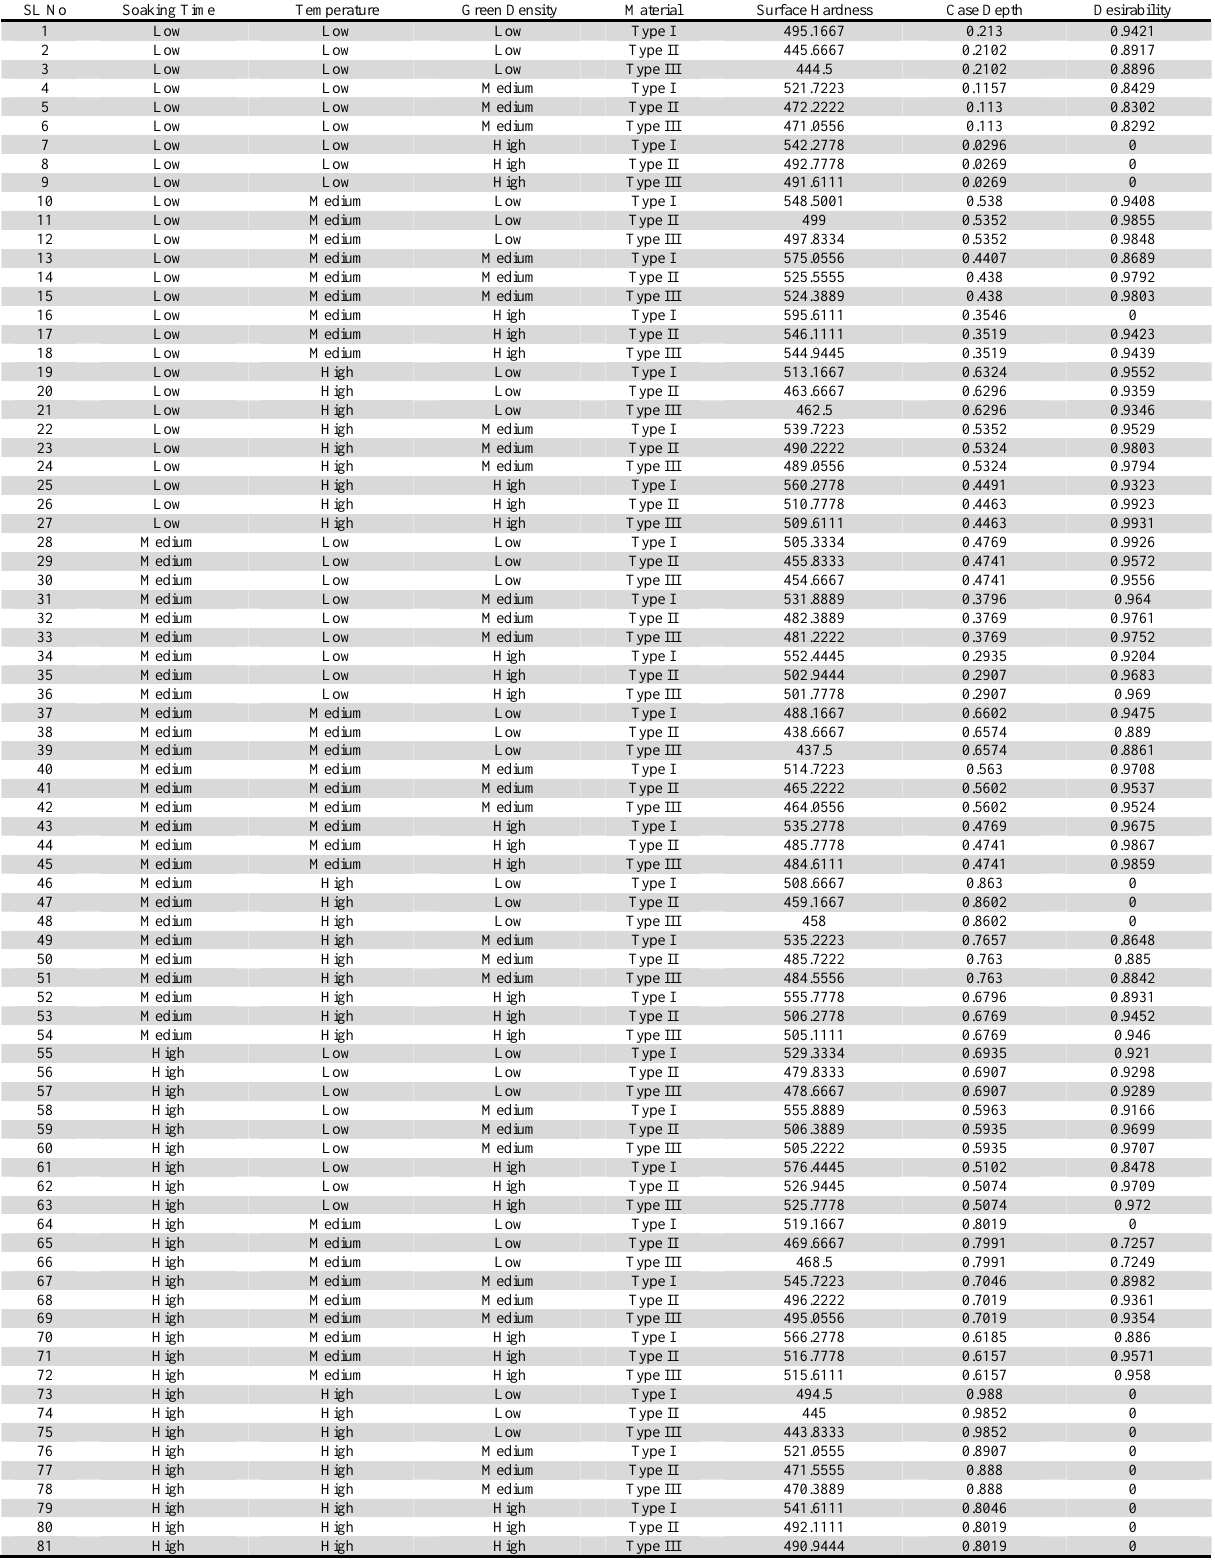
Estimated responses for all possible 81 combinations SL No Soaking